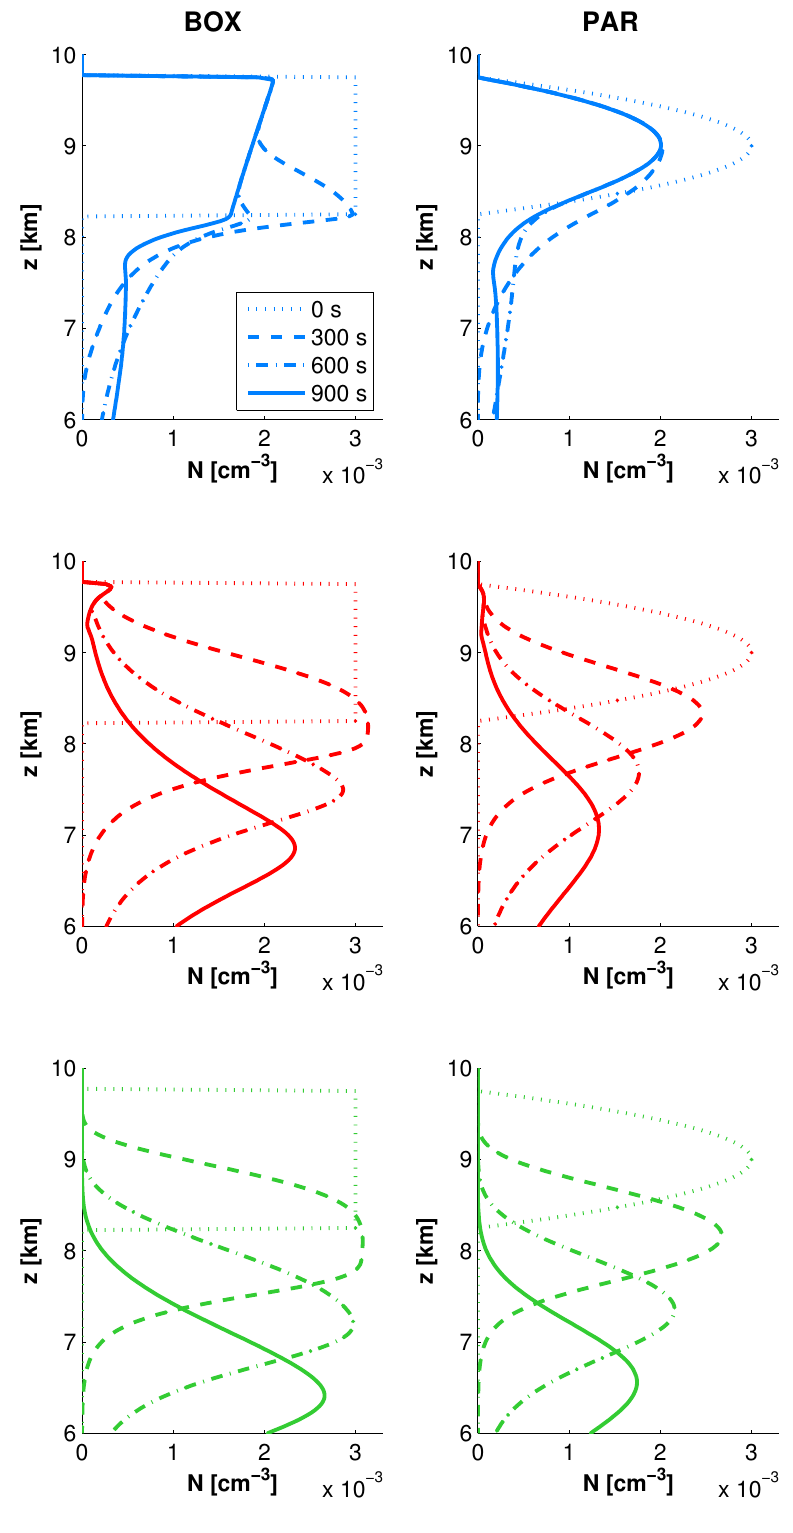
Figure 4. Invariant-signal area: number density profiles from 6 to 10 km. ( Left ) BOX case. ( Right ) PAR case. Top to bottom: results from the MOM3- B model (blue, top), MOM3- Γ model (red, middle) and MOM3-l-n model (green, bottom). For clarity, the reference solution is